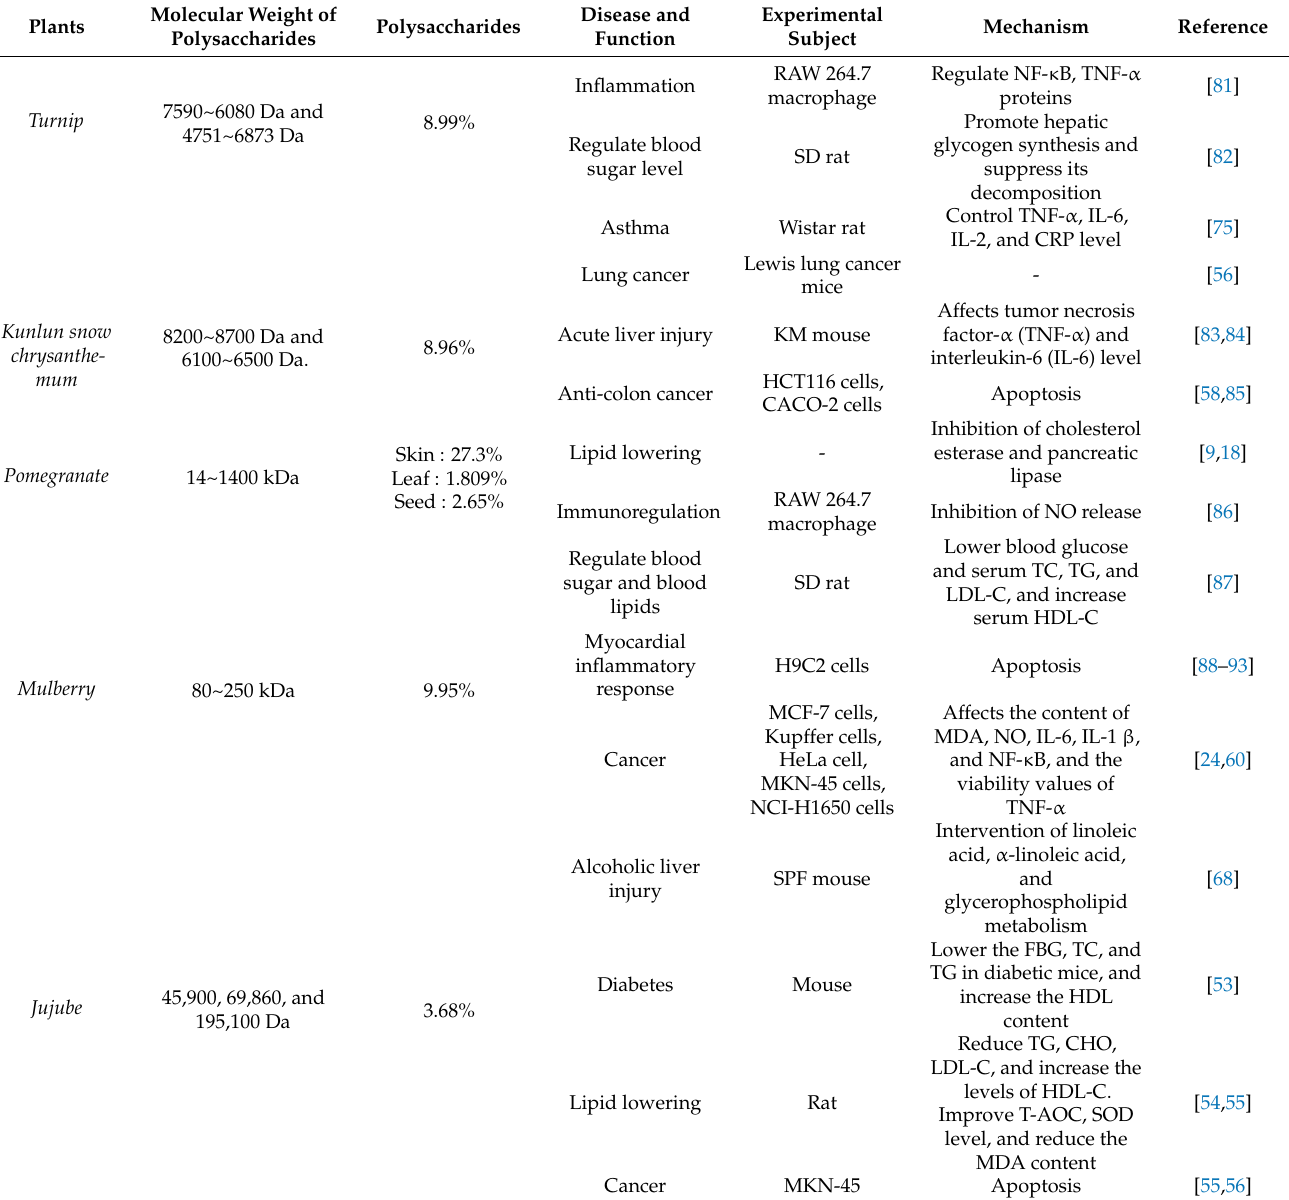
Table 4. Summary of five polysaccharide contents and related